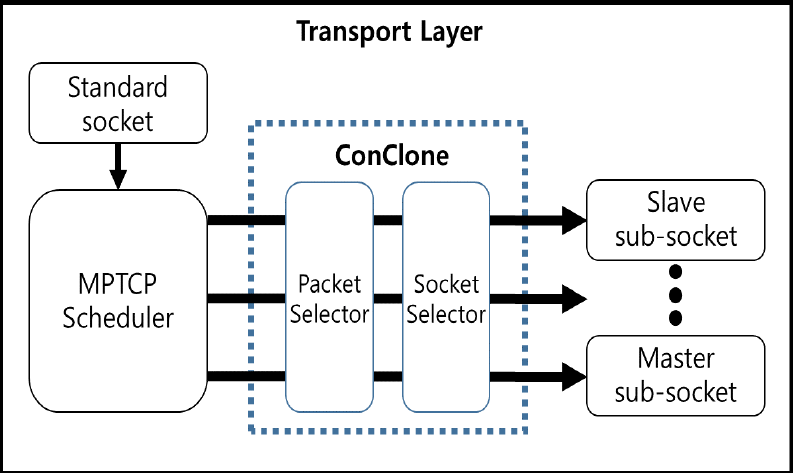
Figure 2. The design of ConClone